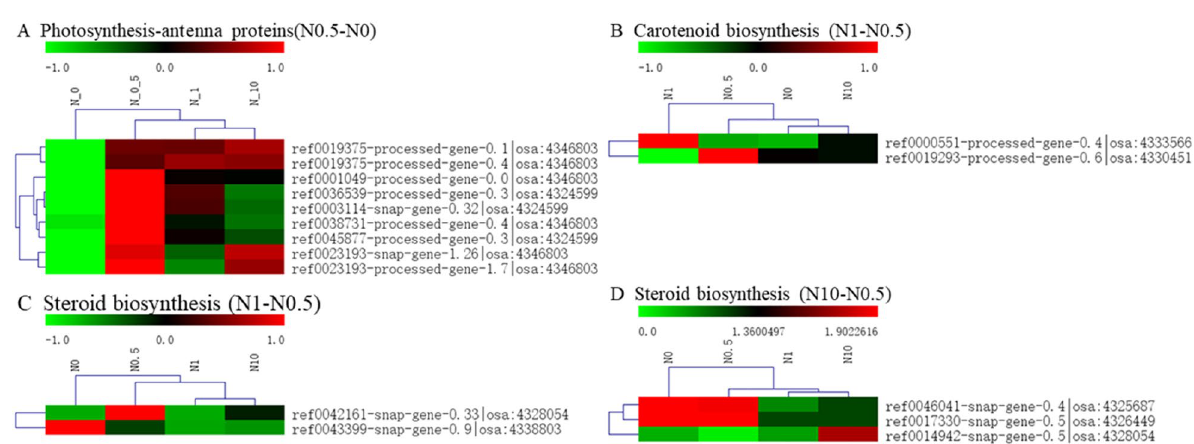
Figure 8. Heat map clustering analysis of DEGs enriched in three pathways. ( A ) represents the clustering of DEGs enriched in the photosynthesis-antenna protein pathway in treatment N0.5 compared to treatment N0. ( B , C ) represent the clustering of DEGs enriched in the steroid biosynthesis pathway and carotenoid biosynthesis pathway in treatment N1 compared to treatment N0.5. ( D ) represents the clustering of DEGs enriched in the steroid biosynthesis pathway in treatment N10 compared to treatment N0.5. High-expression genes are shown in red, and low-expression genes are shown in